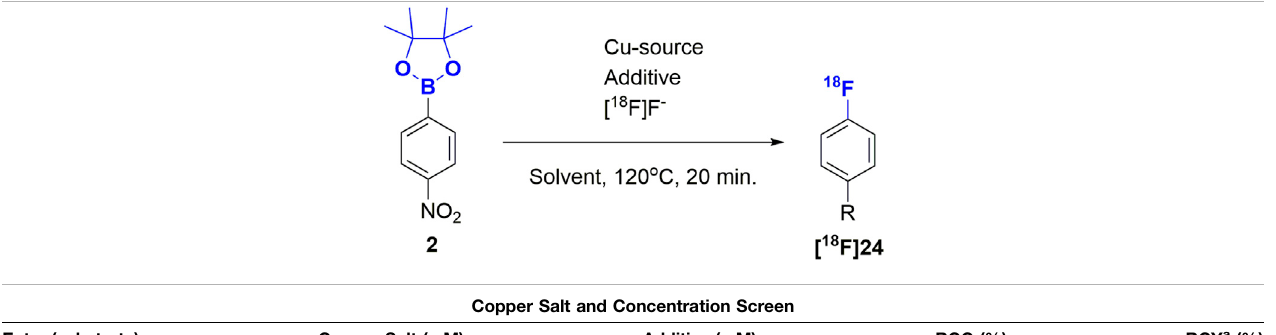
TABLE 3 | Optimization of radiolabeling reaction with [ 18 F] fl uoride.